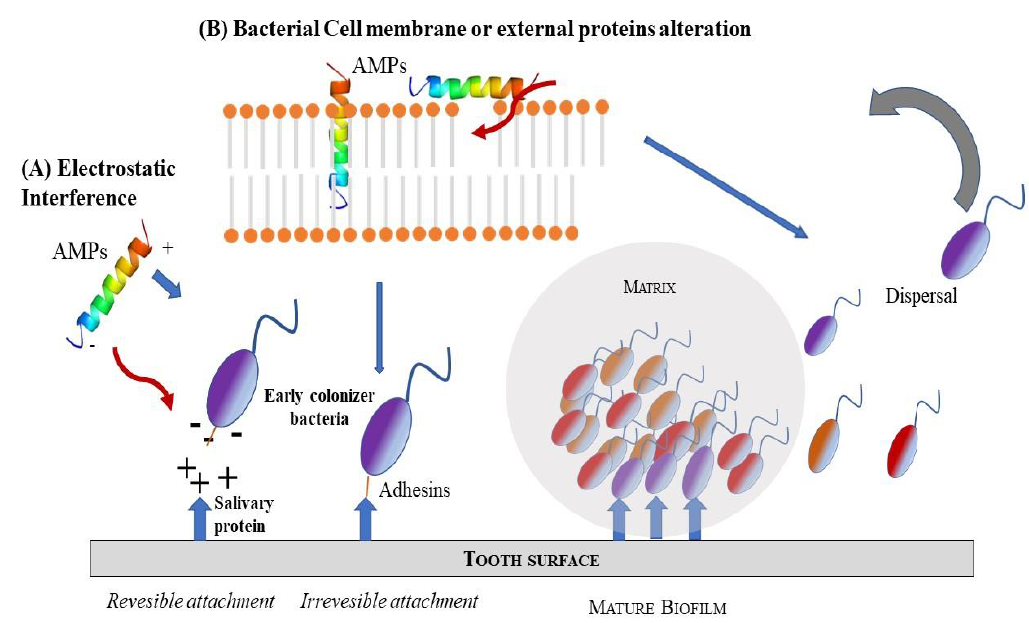
Scheme 3. Schematic representation of two possible mode of AMPs action as antimicrobial agents: ( A ) electrostatic interference; ( B ) bacteria cell membrane or external protein alteration.